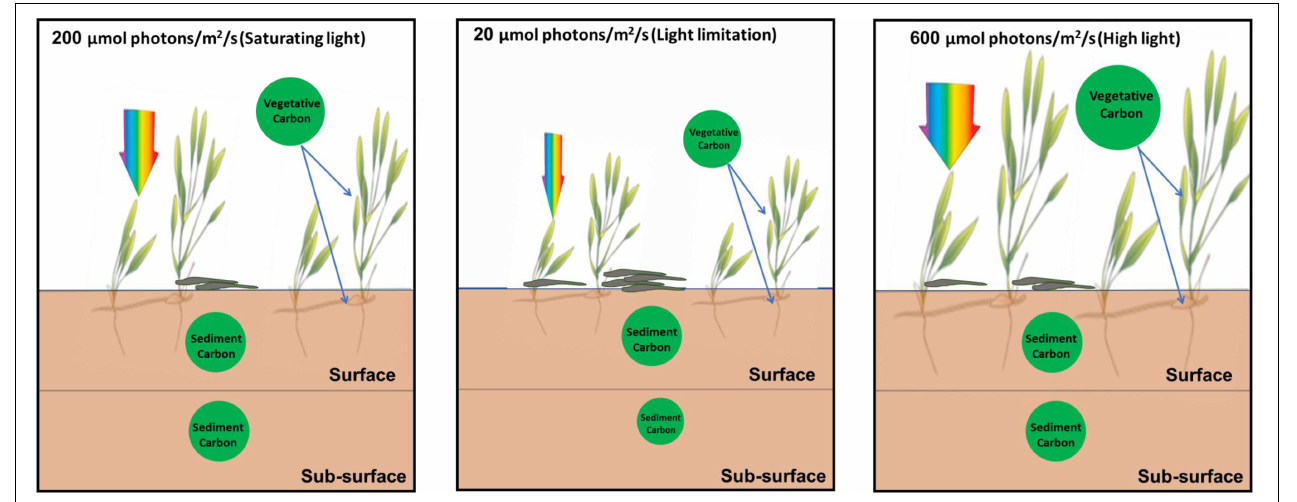
FIGURE 9 | Schematic pictures of the effects of light reduction on the carbon sequestration in seagrass